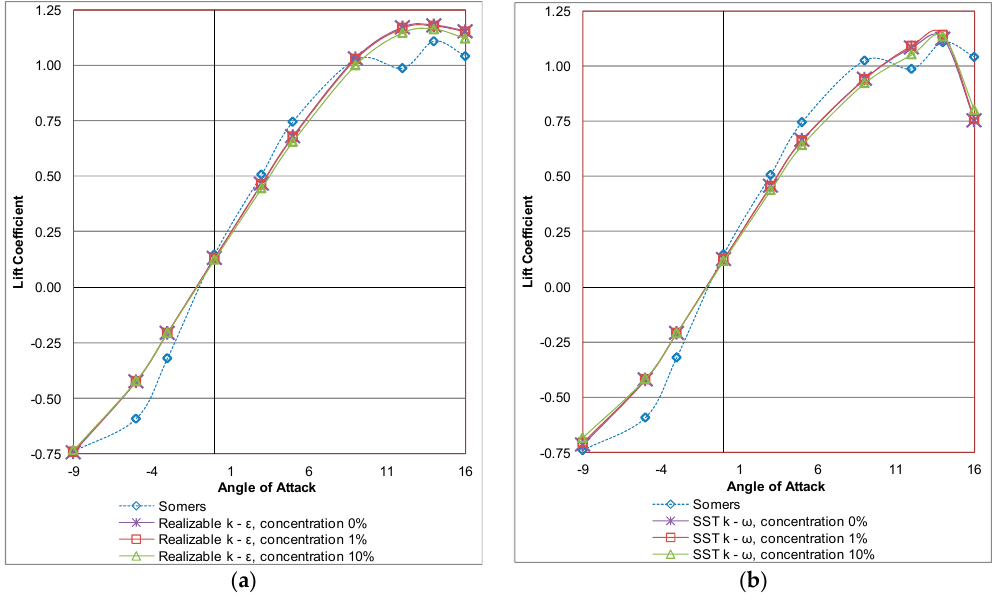
Figure 4. Comparison between reliable experimental data and simulation results of the lift coefficient curve for an S809 airfoil for ( a ) realizable k– ε ; and ( b ) SST k– ω turbulence models at Re = 2 × 10 6 for one-phase and two-phase flows consisting of two different concentrations of sand particles in the air. Figures 5 and 6 depict the simulation results of the drag coefficient for the S809 airfoil versus the angle of attack at Re = 1 × 10 6 and Re = 2 × 10 6 , respectively. For both Reynolds numbers the predicted drag coefficient increases as the angle of attack and the concentrations of sand particles in the air increase. This increase is much more obvious for 10% concentration of sand particles in the air flow.